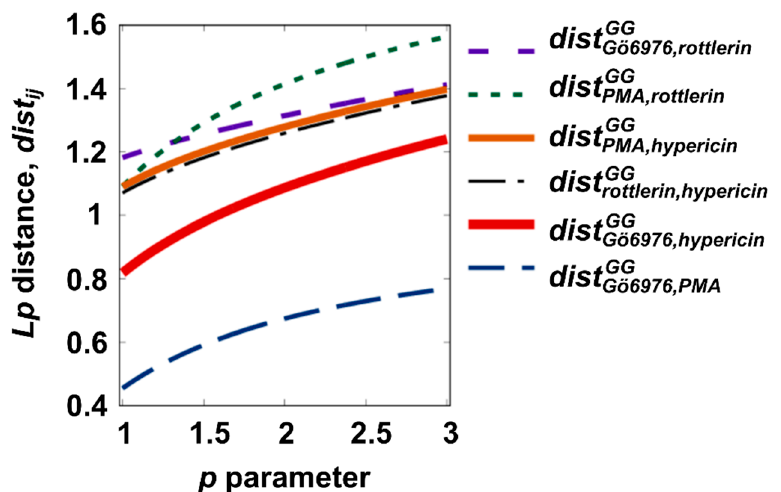
Figure 2. Distances between pairs of measured data patterns. The p parameter is a free parameter used to intentionally modify the distance definition.